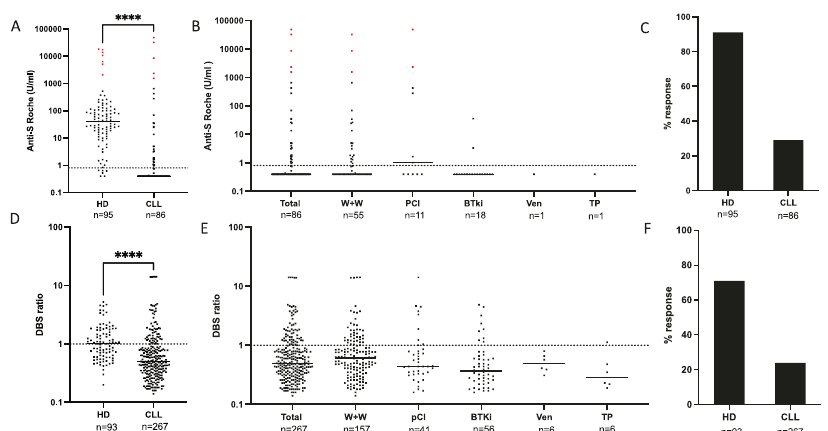
Fig. 2 Antibody responses in patients with CLL following fi rst Covid-19 vaccine. A Antibody responses to SARS-COV19 Spike following fi rst vaccine in sera from healthy donors (HD) and patients with CLL, as measured by Roche assay. Red indicates those previously exposed (PE) to SARS-CoV-2 (median HD 41.6 vs CLL 0.4 (104 fold change)); cut off for positivity at 0.8 shown by dotted line. B Antibody responses to SARS- CoV-2 Spike in patients with CLL following fi rst vaccine, by management stage, as measured by Roche (Total patients; Watch and Wait (W + W); Previous Chemo-immunotherapy but not on active therapy (pCI); Bruton Tyrosine Kinase therapy (BTKi); Venetoclax therapy (Ven); Treatment planned (TP). C Bar chart to show the percentage response after fi rst vaccine in healthy donors and CLL measured by Roche. D Antibody responses to SARS-CoV-2 Spike from DBS in healthy donors (HD) and patients with CLL, as measured by The Binding Site (TBS) assay using DBS eluates (median 1 vs 0.5; p < 0.0001; (cut off positivity shown at 1). E Antibody responses to SARS-CoV-2 Spike in patients with CLL following fi rst vaccine, by management stage, as measured by TBS using DBS eluates (Kruskal – Wallis p = 0.0054; post hoc Dunn ’ s analysis p < 0.0056 W + W vs BTKi). F Bar chart to show the percentage response after fi rst vaccine in HD and CLL measured by TBS using DBS